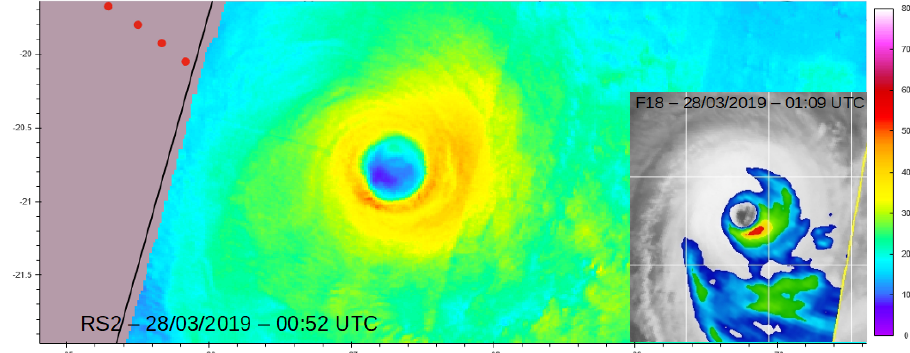
Figure 8. RS-2 3-km wind speed product for TC JOANINHA on the 28 March 2019. Units are m · s − 1 . On the lower right corner, a concomitant F17 SSMI/S overpass (polarization corrected temperature product) associated with MSG-1 IR imagery. Microwave imagery courtesy of Naval Research Labotory/US Navy. SAR product obtained from Ifremer/Cyclobs and produced with SAR wind processor co-developed by IFREMER and